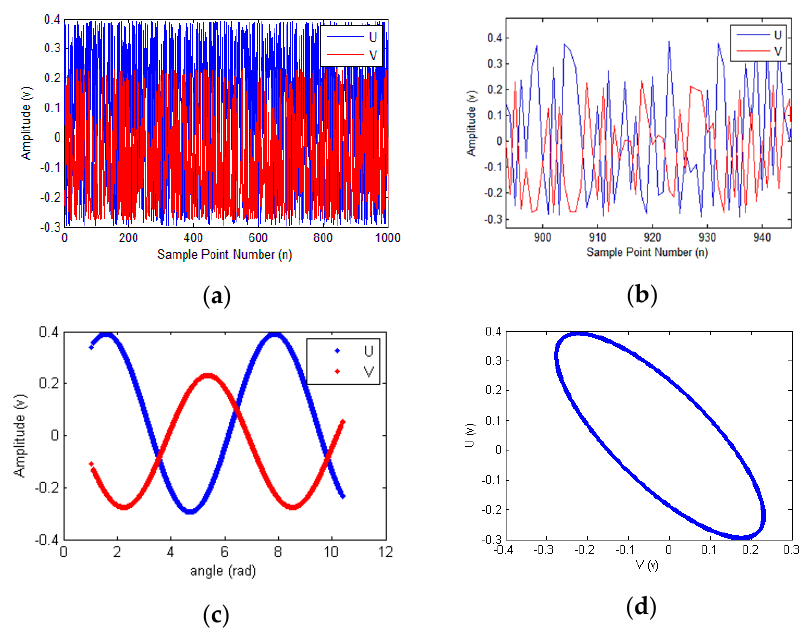
Figure 7. Signals for the simulation. ( a ) Signal amplitude for each sample point; ( b ) details of (a) showing the discontinuity of the signal; ( c ) signal amplitude as a function of input angle; ( d ) Lissajous figure for the simulation signals.